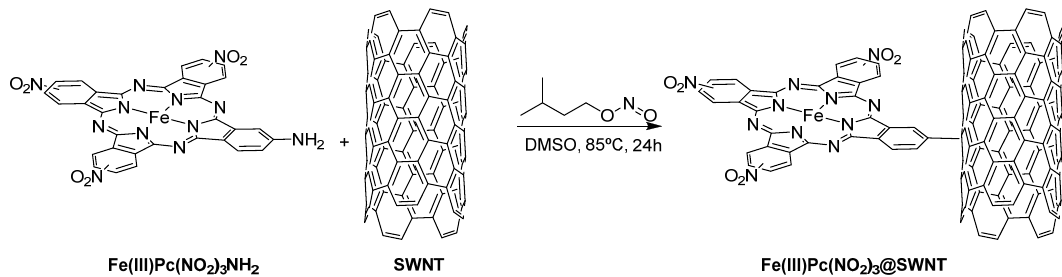
Figure 7. Synthetic route for the preparation of the MPc covalently supported on carbon fiber, Fe(III)Pc(NO 2 ) 3 @SWNT (Adapted from [56]).